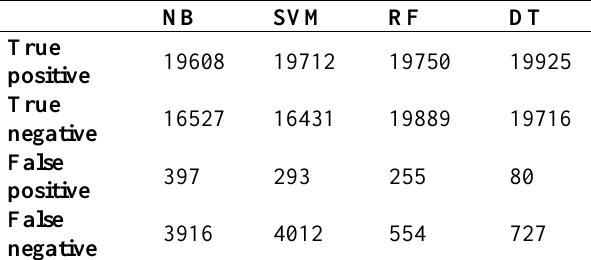
Table 13. Experiment with 7